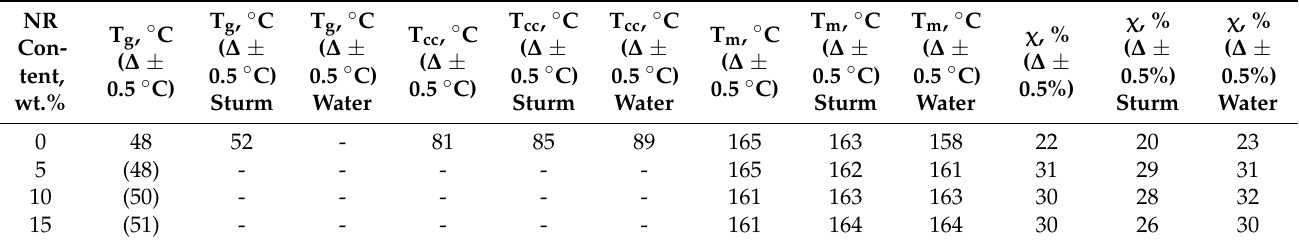
Table 1. Thermophysical characteristics of PLA/NR film samples: before and after biotic and hydrolytic degradation.